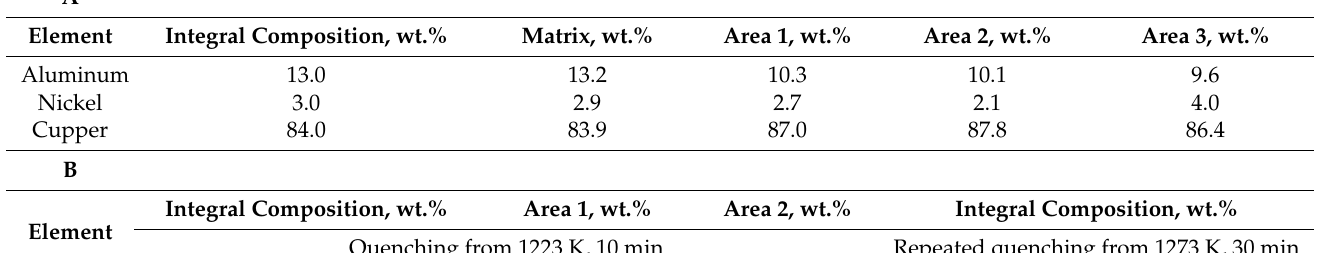
Figure 8. ( а ) OM image of the Cu-14Al-3Ni alloy, SEM images in an EBS mode of the alloys ( b ) Cu- 13Al-3Ni and ( c ) Cu-14Al-3Ni after quenching [46].